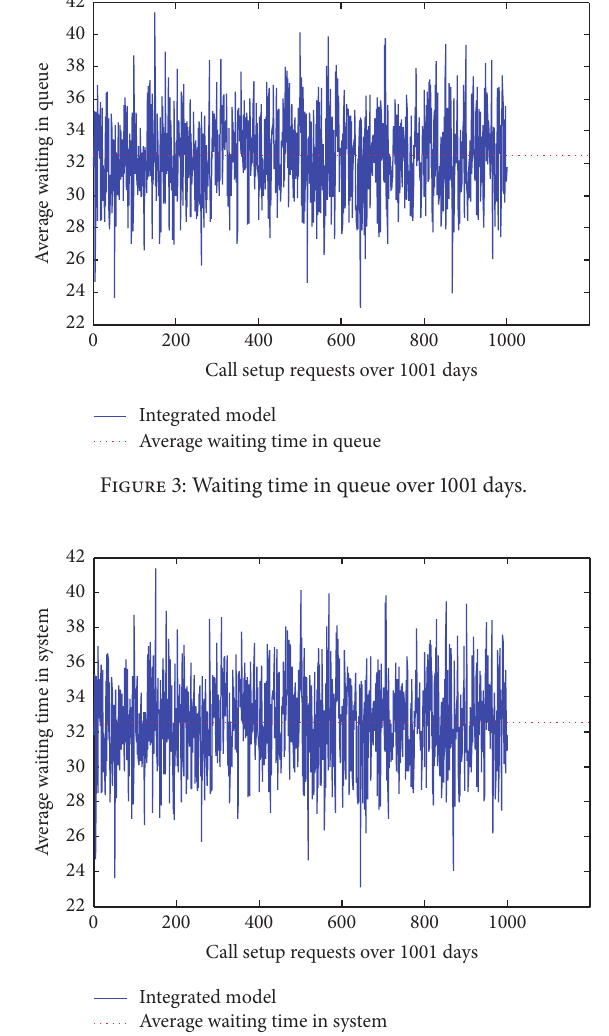
Figure 4: Waiting time in system over 1001